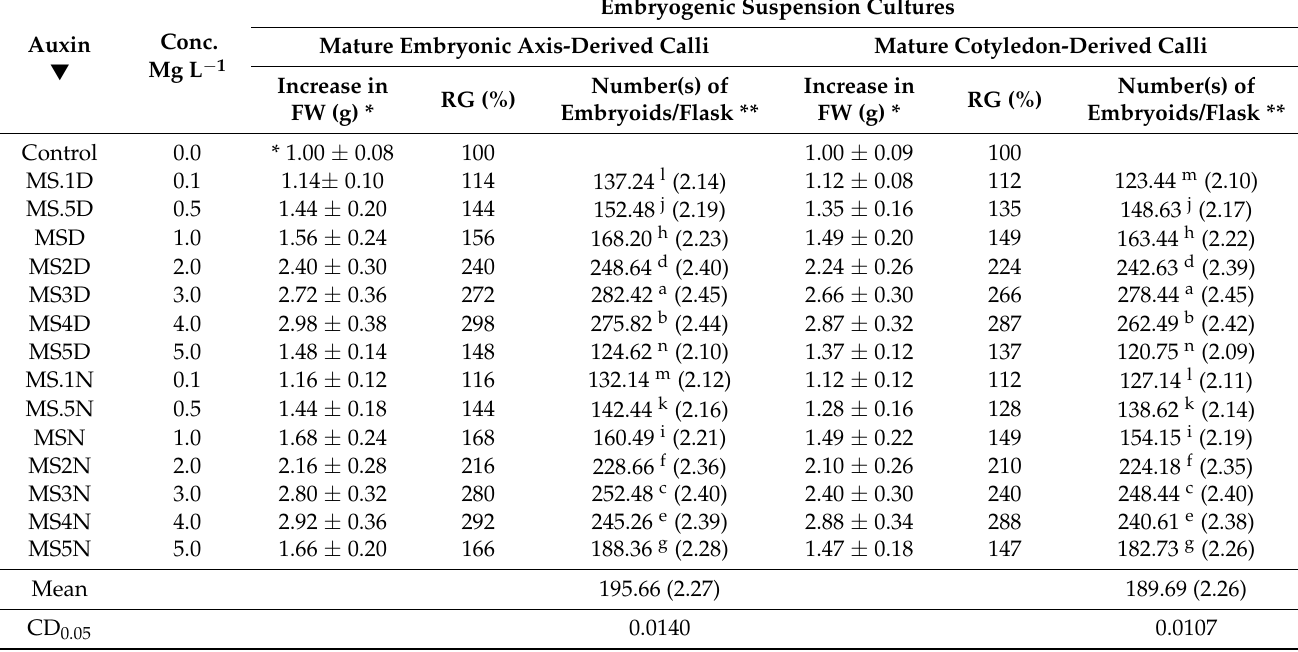
Table 1. Influence of diverse auxins (alone) in varying levels on growth of cell suspension